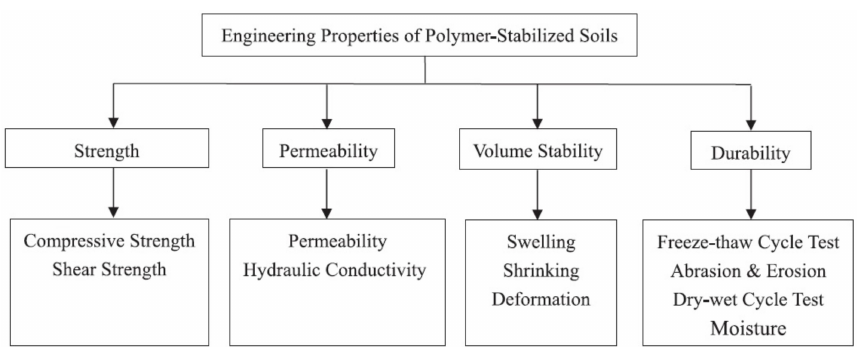
Figure 9. Methods to evaluate the effectiveness of soil stabilization using polymers. Reprinted with permission from ref. [31]. 2022,